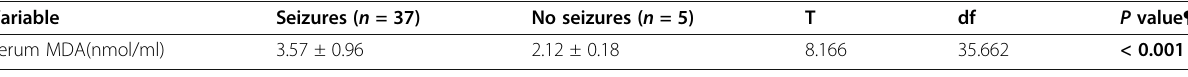
Table 1 Relationship between MDA and occurrence of seizures